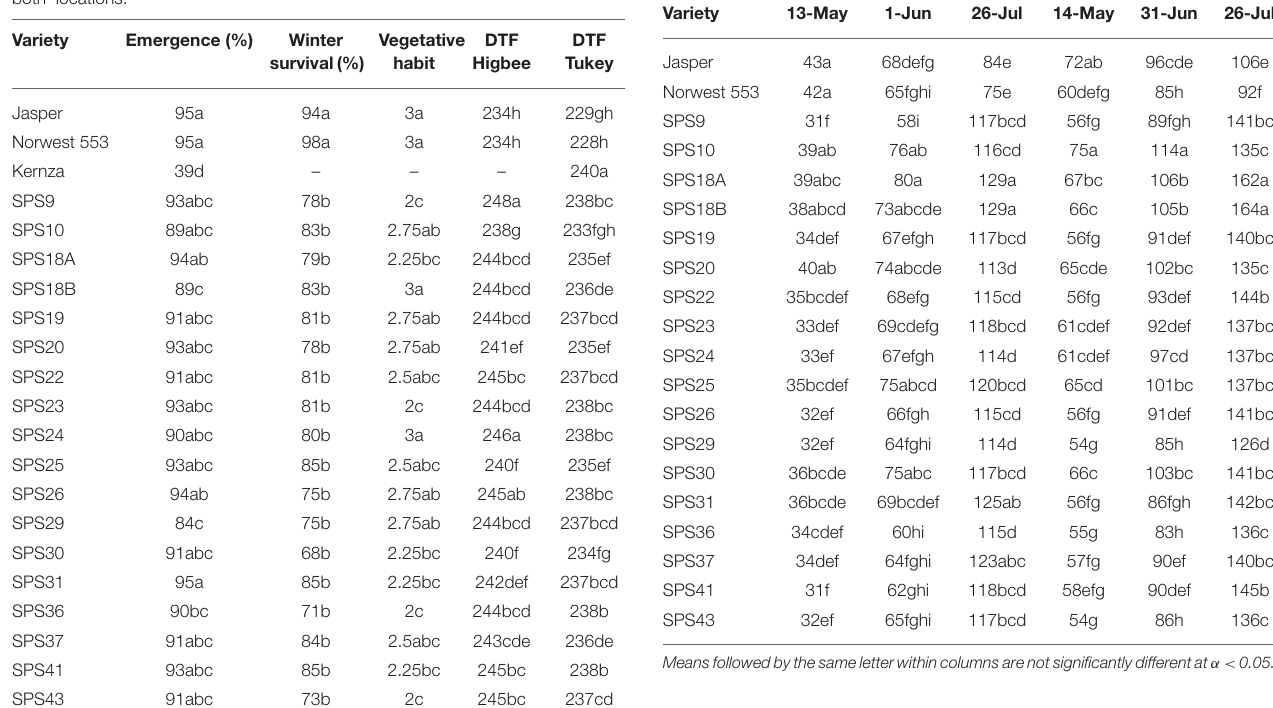
TABLE 1 | Growth characteristics of annual wheat (Jasper and Norwest 553), amphiploid lines and wheatgrass (Kernza) including emergence, first-year winter survival during establishment, vegetative growth habit (1 = planophile, 2 = intermediate, 3 = erectophile) at Higbee and days to flowering (DTF) at both locations.